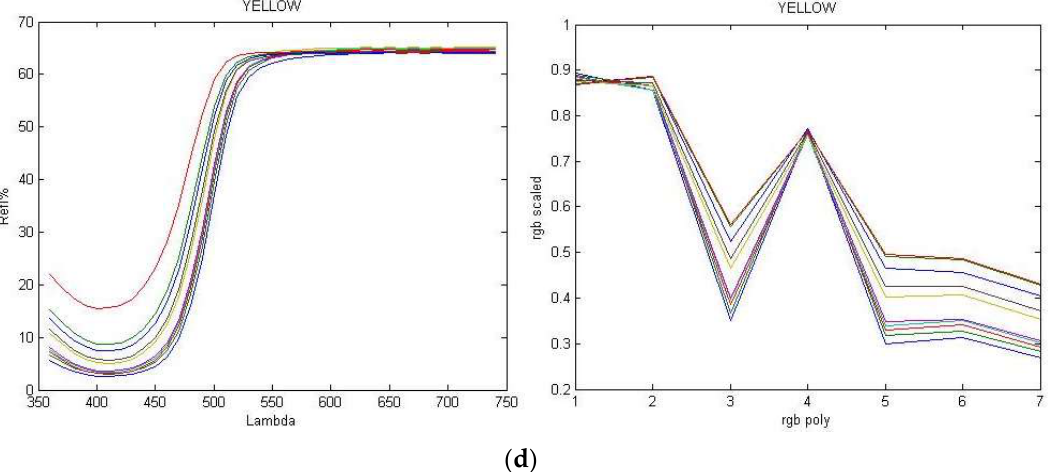
Figure 6. ( a ) r, g, b, rg, rb, gb, and rgb readings and SCE reflectance reading of red; ( b ) r, g, b, rg, rb, gb, and rgb readings and SCE reflectance reading of cyan; ( c ) r, g, b, rg, rb, gb, and rgb readings and SCE reflectance reading of blue; ( d ) r, g, b, rg, rb, gb, and rgb readings and SCE reflectance reading of yellow.